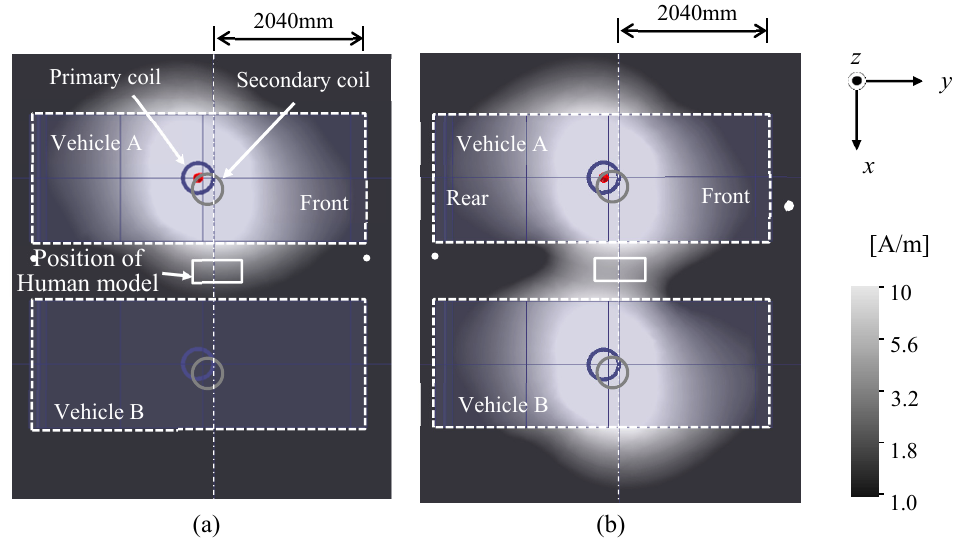
Figure 4. Distribution of leakage magnetic field in x-y place at z = 120 mm for ( a ) only vehicle A being charged and ( b ) both vehicles being